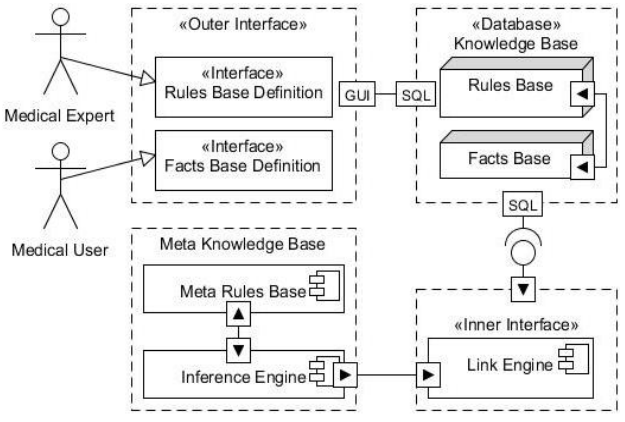
Fig. 1. Architectural design of a general medical fuzzy